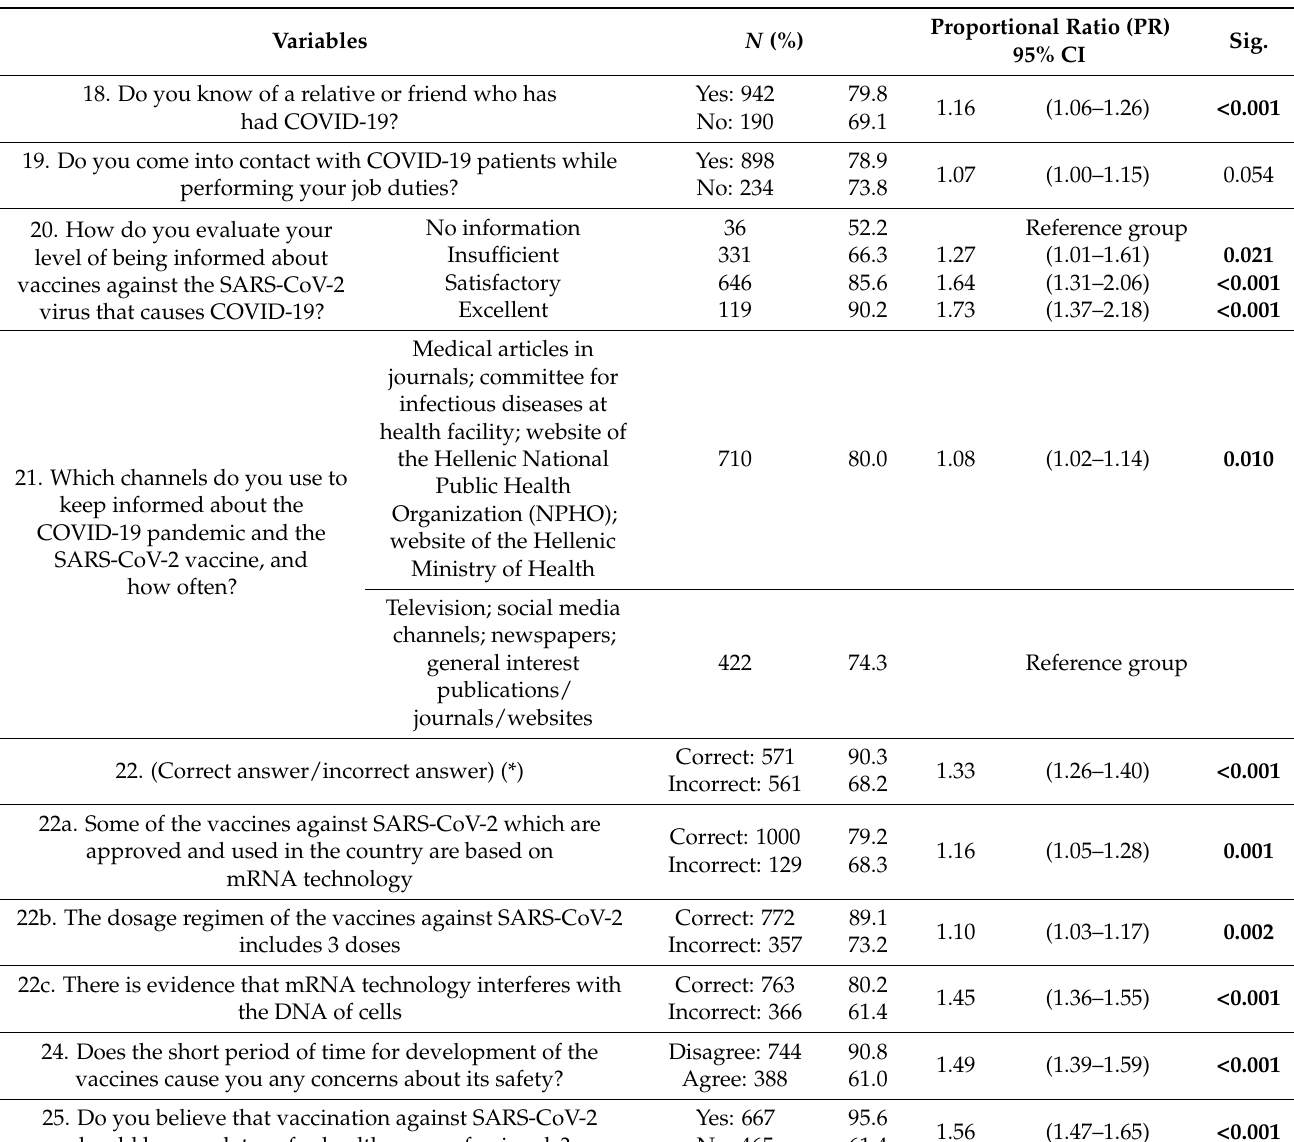
Table 4. Section B questions “knowledge and hesitancy regarding vaccines against SARS-CoV-2” associated with COVID-19 vaccine acceptance, expressed with proportional ratio in univariate